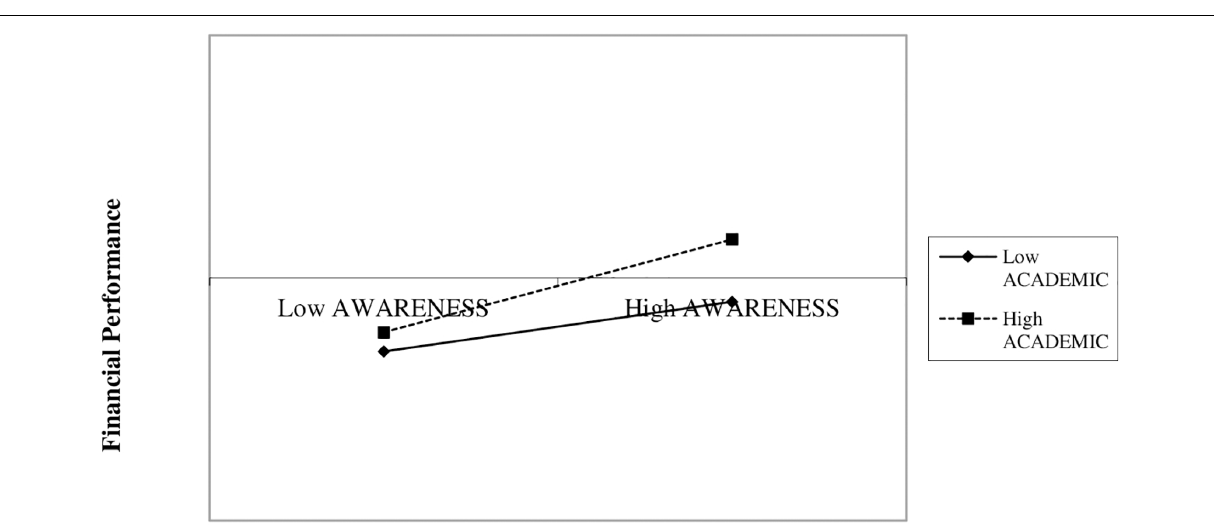
FIGURE 4 | Two-way interaction. AWARENESS * ACADEMIC. AWARENESS, brand awareness, as the goal of the company; ACADEMIC, academic background of the female